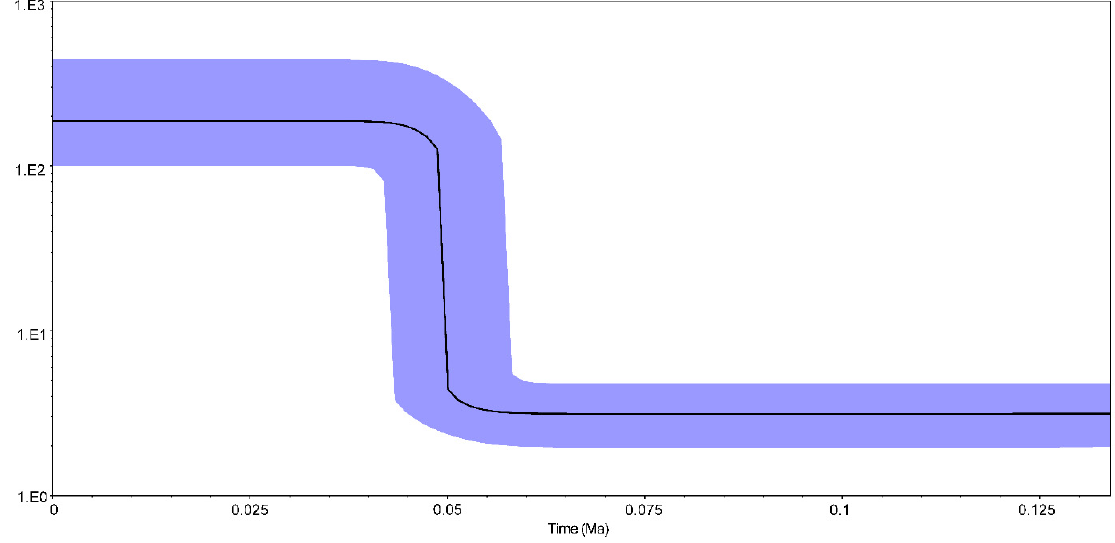
Figure 3. Bayesian skyline plots of Anguilla japonica based on a 2.55% evolutionary rate.